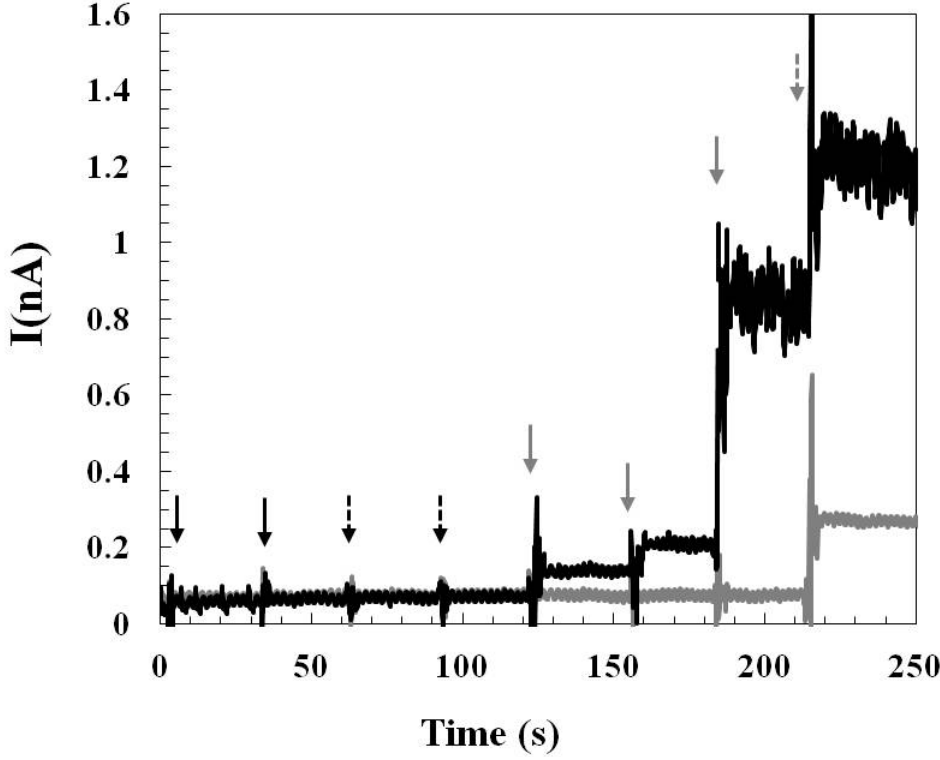
Figure 3. A representative result of sensing current responses by testing the glutamate sensor prepared by Method 2 ( ▬ black line ) and the control sensor ( ▬ gray line )